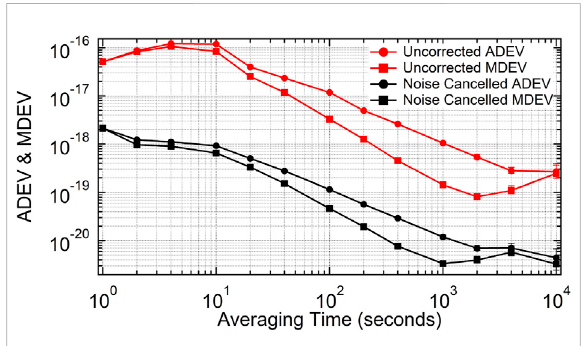
FIGURE 6 Red dot and square: Allan deviation and modi fi ed Allan deviation of uncorrected f beat signal at 1,064 nm. Black dot and square: Allan deviation and modi fi ed Allan deviation of noise cancelled f beat signal at 1,064